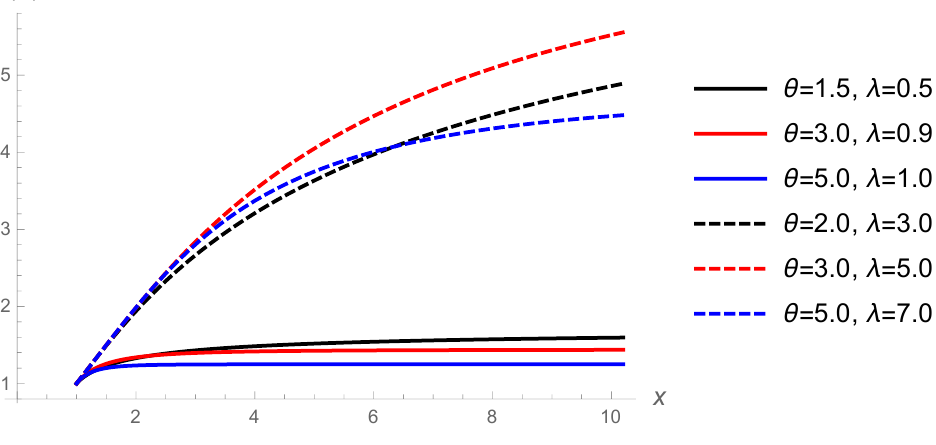
Figure 4. Limited expected value function of GTLG distribution for selected values of θ and λ when α =